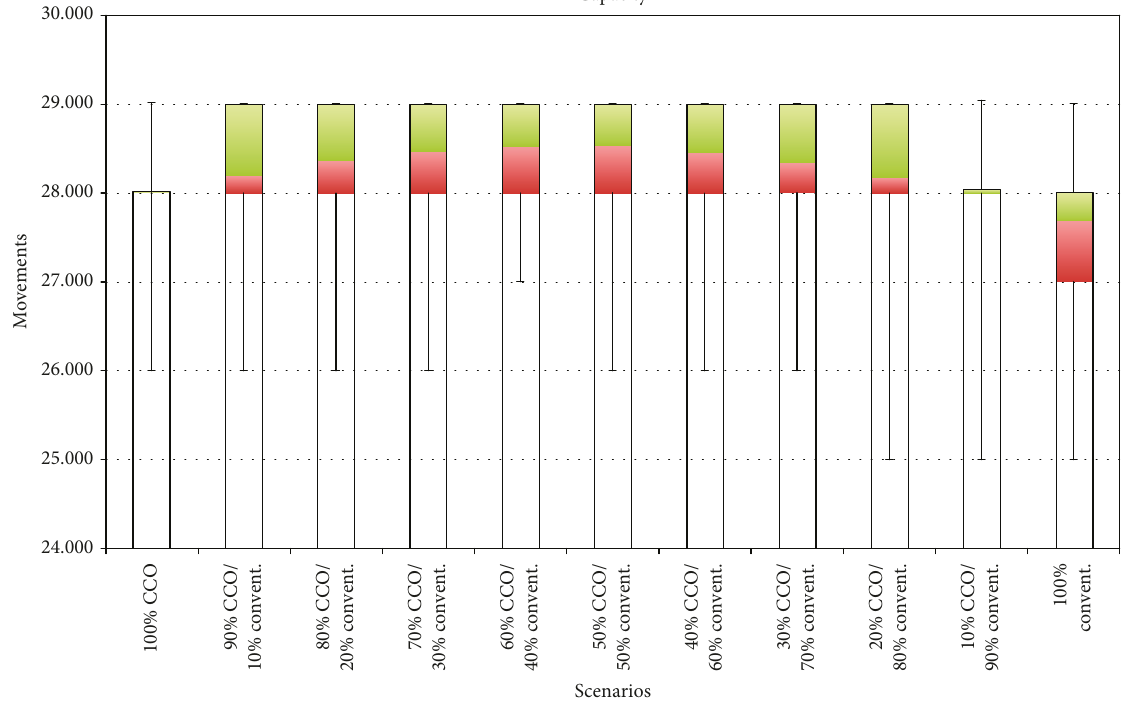
Figure 4: Capacity. Maximum number of aircraft that can be accommodated per hour according to aforementioned